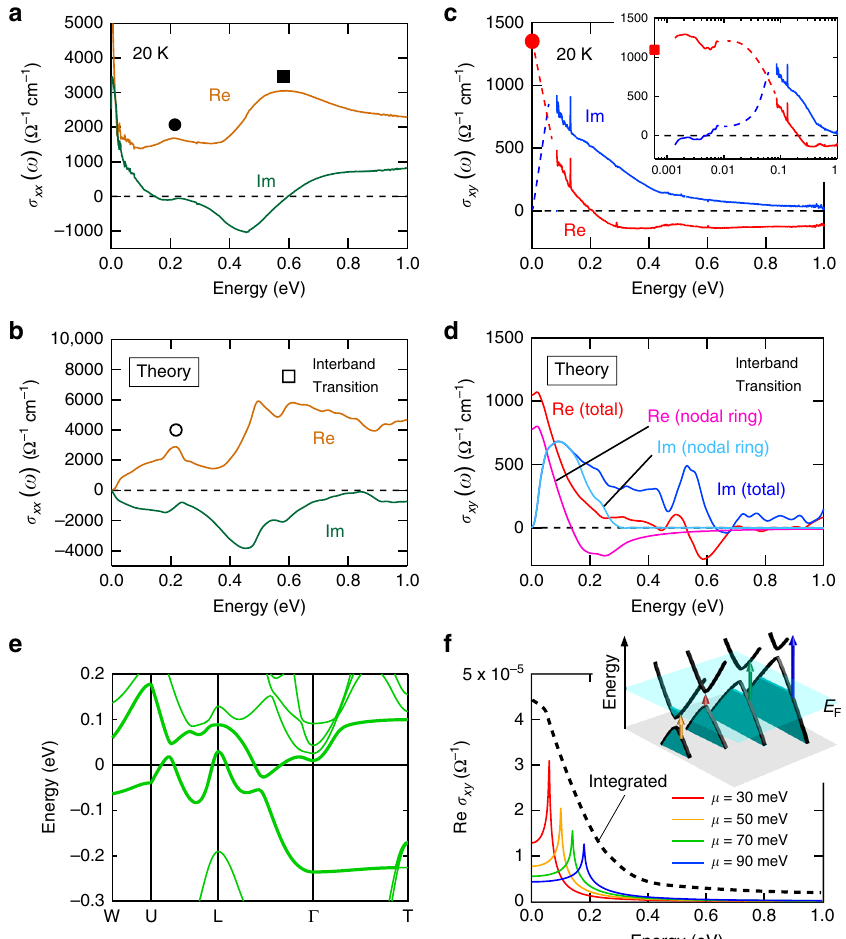
Fig. 3 Longitudinal optical conductivity and optical Hall conductivity spectra obtained from the experiment and fi rst-principles calculation. Experimental ( a ) longitudinal optical conductivity spectra σ xx ( ω ) and ( c ) optical Hall conductivity spectra σ xy ( ω ). The red circle at zero energy in c represents the DC value of the σ xy of the bulk single crystal. The inset of c shows the optical Hall conductivity spectra including the terahertz spectra on the logarithmic energy scale. The red square at zero energy in the inset of c represents the DC value of the σ xy of the thin fi lm. The dashed lines in c for a photon energy region of 8 – 80 meV, where the MO measurements could not be done, represent the anticipated connections between the experimental σ xy ( ω ) values in THz/DC and infrared regions, assuming that no sharp resonance structure is present in this narrow energy window. Theoretical ( b ) longitudinal optical conductivity spectra σ xx ( ω ) and ( d ) Hall conductivity spectra σ xy ( ω ) (see Method). In d , the red and blue curves represent the σ xy ( ω ) spectra which take into account all band structures, while the pink and light blue ones show the σ xy ( ω ) arising from the topological bands indicated by bold lines in e . These theoretical calculations include only the interband transition, so that the response from the intraband transition or Drude response of conduction electrons is omitted. e The band structure obtained from the calculation considering the renormalization factor. The two bands indicated by bold curves compose the anti-crossing lines and Weyl points. f Optical Hall conductivity σ xy ( ω ) calculated for a single anti-crossing point in the two- dimensional electronic structure with mass gap m = 0.02 eV and chemical potential μ = 0.03 eV (red), 0.05 eV (orange), 0.07 eV (green), 0.09 eV (blue). The dotted line illustrates the schematic curve of the integrated sum of these resonances arising from the dispersive nodal ring. (Inset) Schematic illustration of the optical transitions on the cross-sections of the dispersive anti-crossing